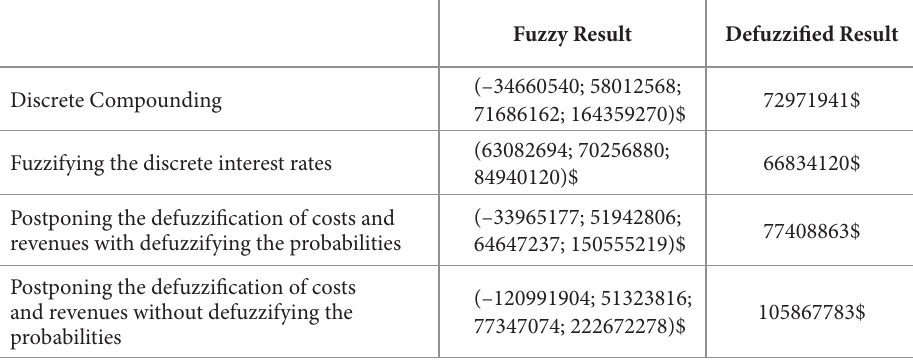
table 2. The results of the application with suggested